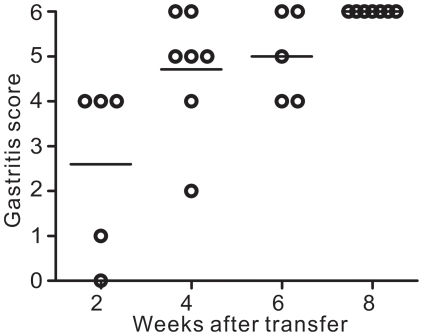
Severity of autoimmune gastritis correlates to stomach weight.Mice were killed at indicated time points after transfer of CD4+ T cells from H/Kα−/− mice and the severity of autoimmune gastritis was determined. Data were pooled from six independent experiments. Each circle represents the data from one mouse. Bars, mean.